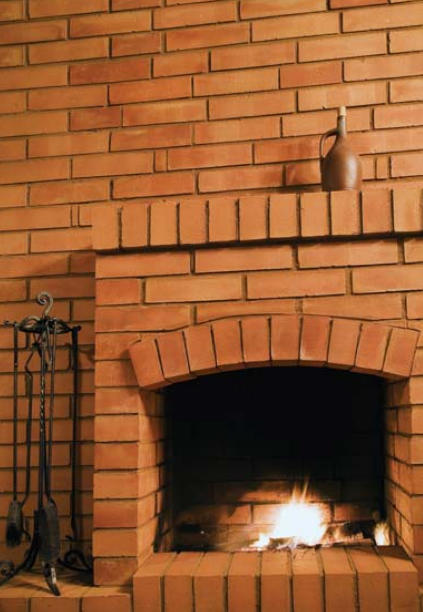
MasonryStone or brick fireplaces and walls stabilize interior temperatures.